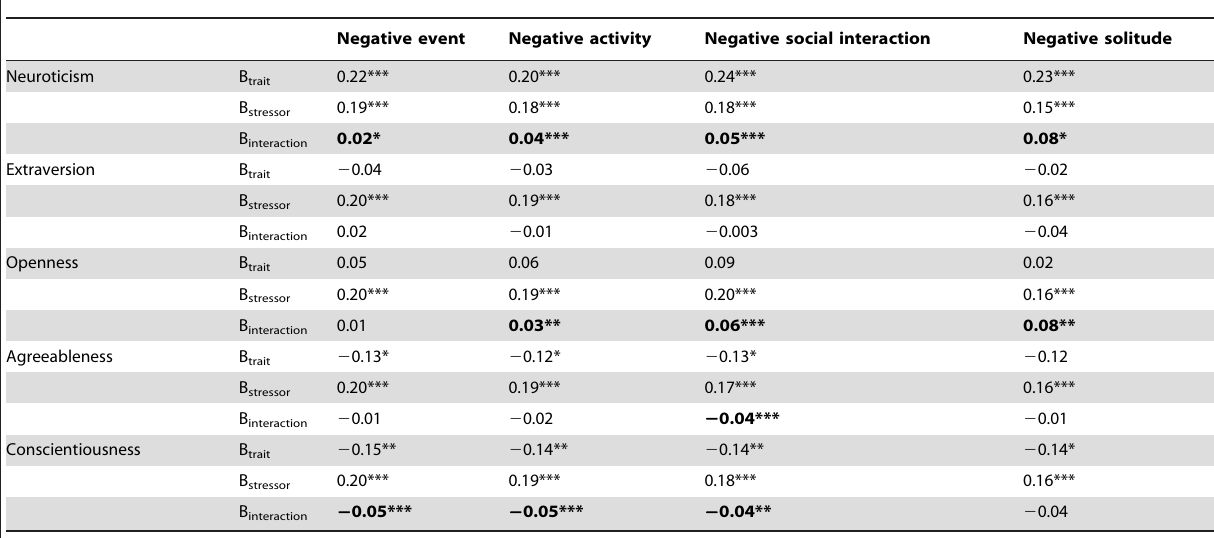
Table 6. Standardized regression coefficients from Model